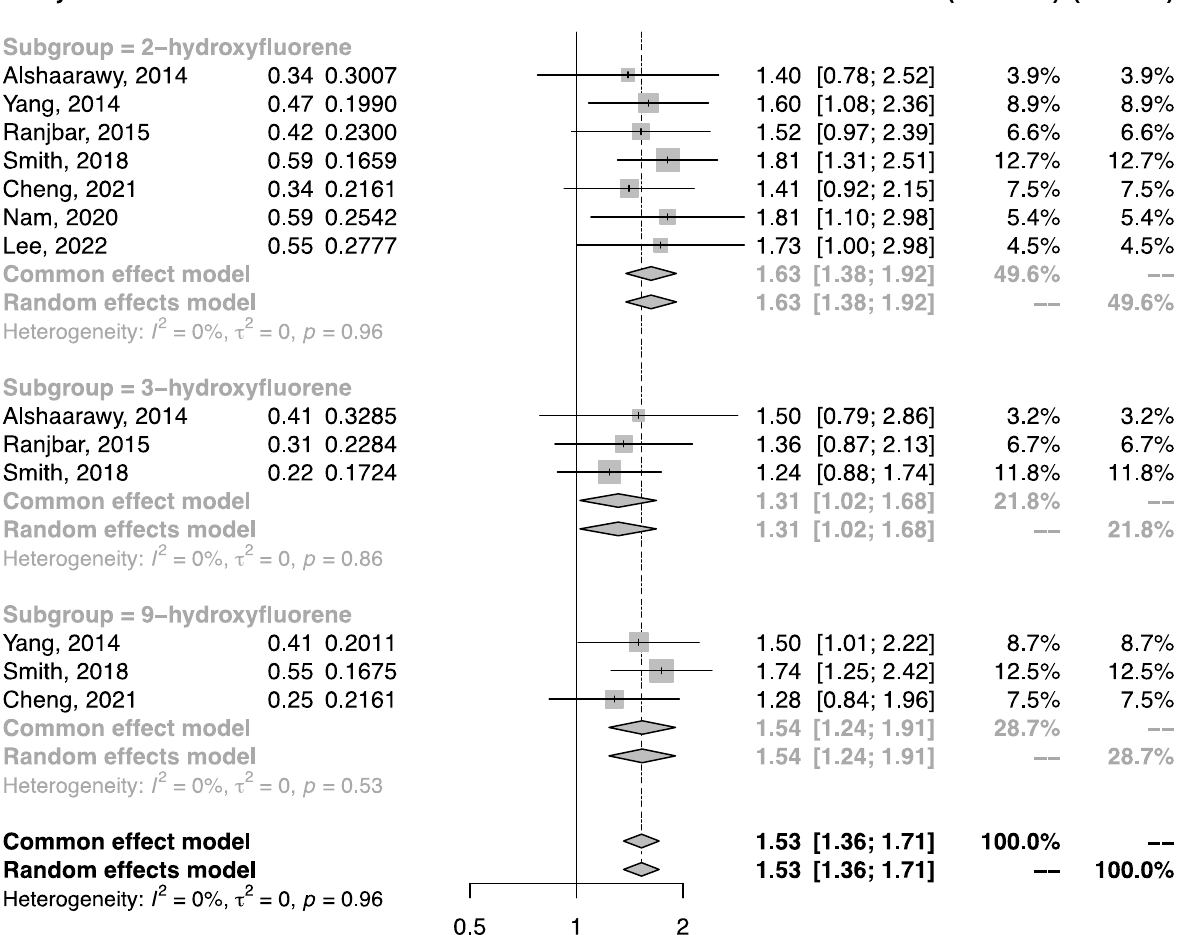
Figure 3. The association between urinary FLU metabolites and risk of T2DM [20–25,28]. Quantitative analysis in the occupational population was not performed because only two studies were included. The results for the same types of PAH metabolites in both studies are shown in Figures S5–S8. The results for most PAH metabolites were not significant in the coke oven workers, except for 4-OHPh which was reported to have a dose-dependent association with the risk of T2DM